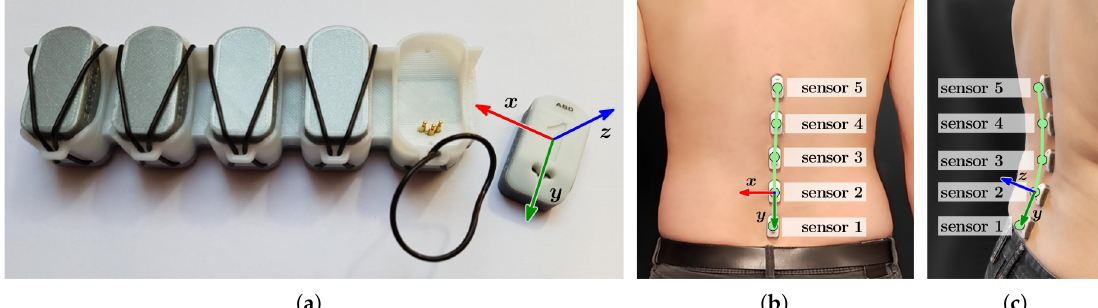
Figure 1. Photos of the SpineTracker sensor system. ( a ) Four of the five sensors are sitting in the charger. The sensor outside the charger is shown with its local coordinate system. A single sensor has the dimensions 33mm × 16mm × 10mm. Each sensor is attached to a person’s lumbar spine with double sided tape. ( b , c ) Back and side view of sensor positioning on the lumbar spine including directions of the sensor coordinate system. Sensors are overlayed with a reconstructed spine curve (green dots and